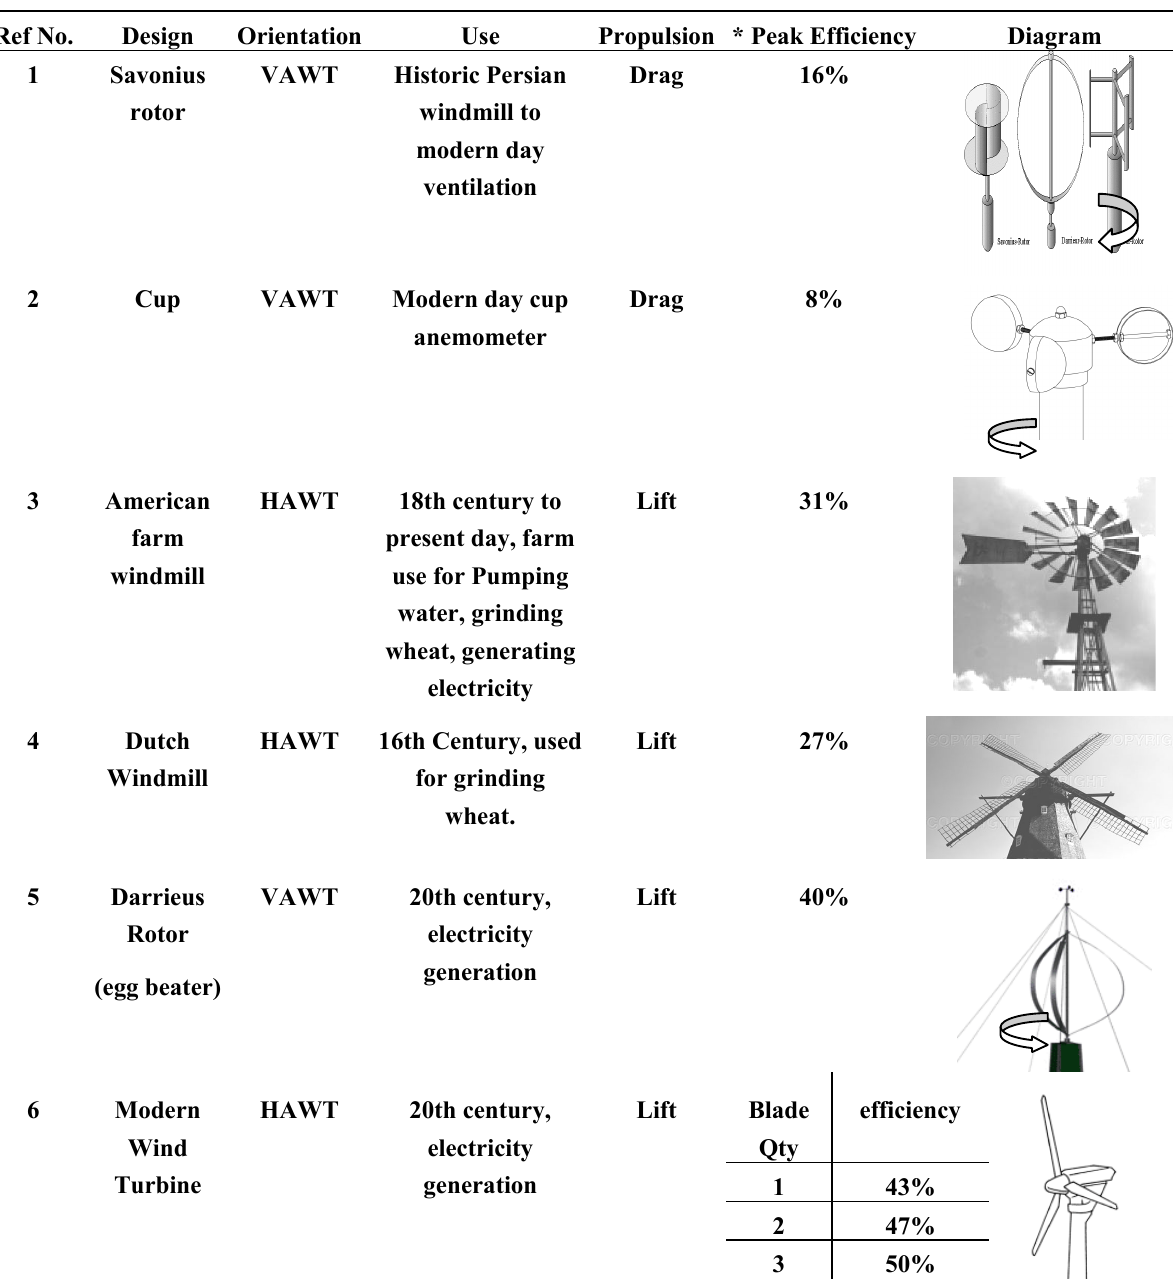
Table 2. Modern and historical rotor